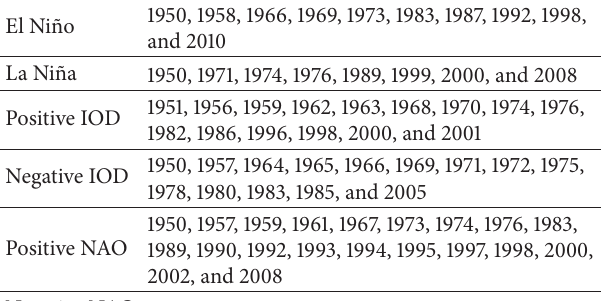
Table 2: Years used in composite study for El Ni˜no, NAO, and IOD (JFM except OND for